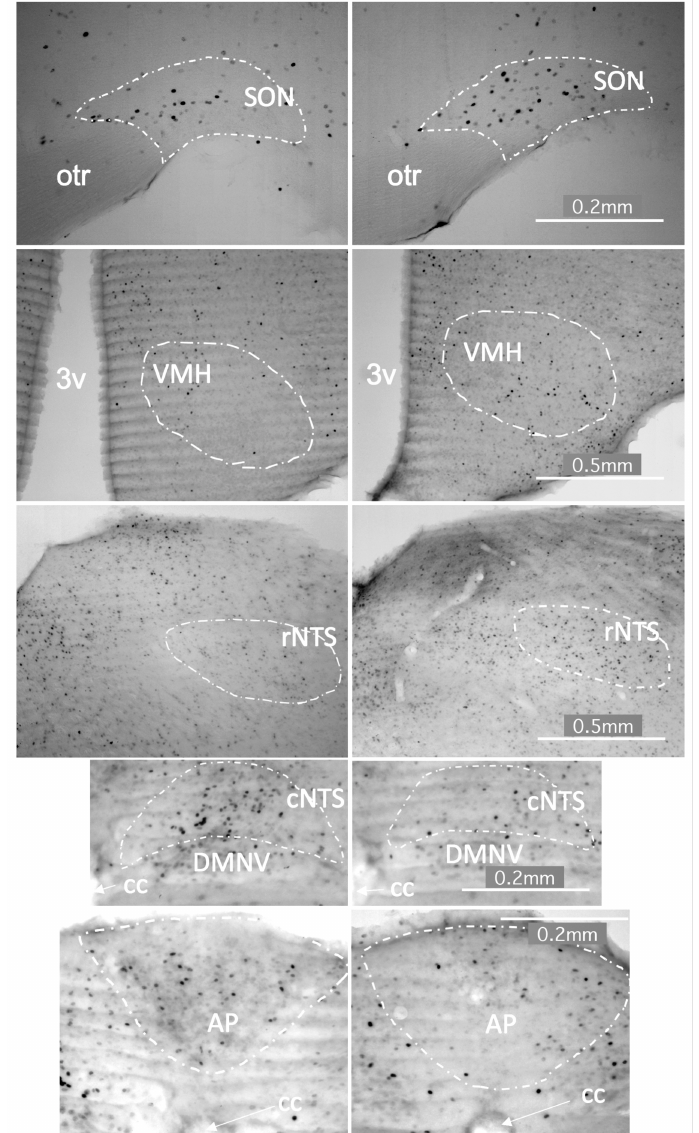
Figure 5. Photomicrographs depicting feeding-related brain sites in which c-Fos immunoreactivity was different after ingestion of the same volume of the 20:80 ( left panel ) vs. 60:40 ( right panel